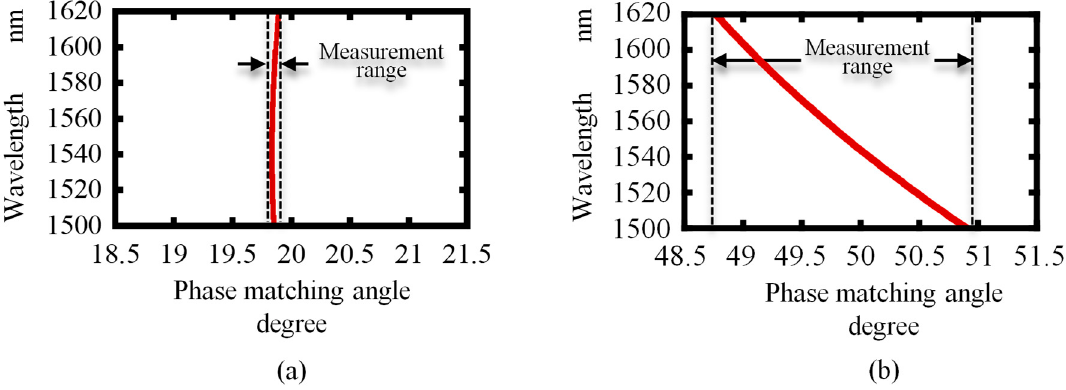
Figure 3. Wavelength-dependent phase-matching angle: ( a ) BBO; ( b ) MgO: LiNbO 3 .